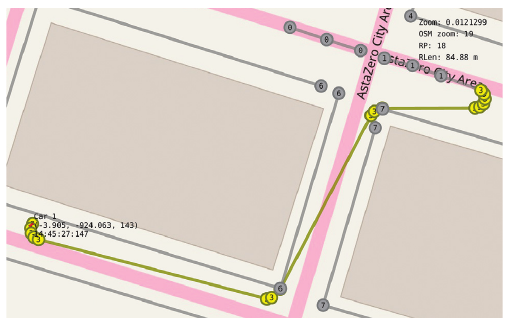
Figure 11: Trajectory from Figure 10 after the optimization pass, new length: